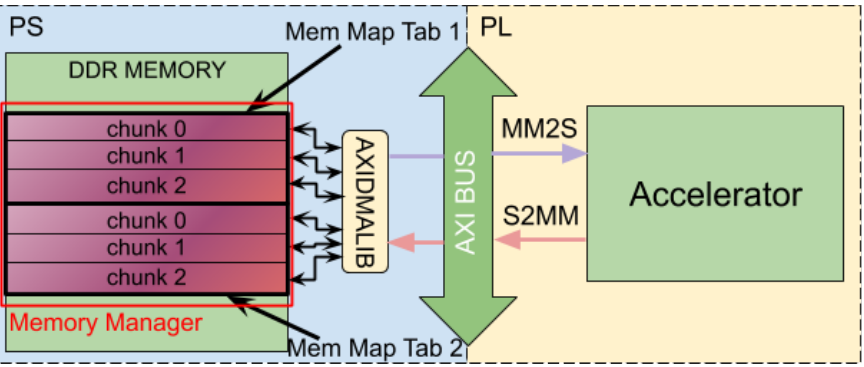
Figure 4. Memory organization for software API